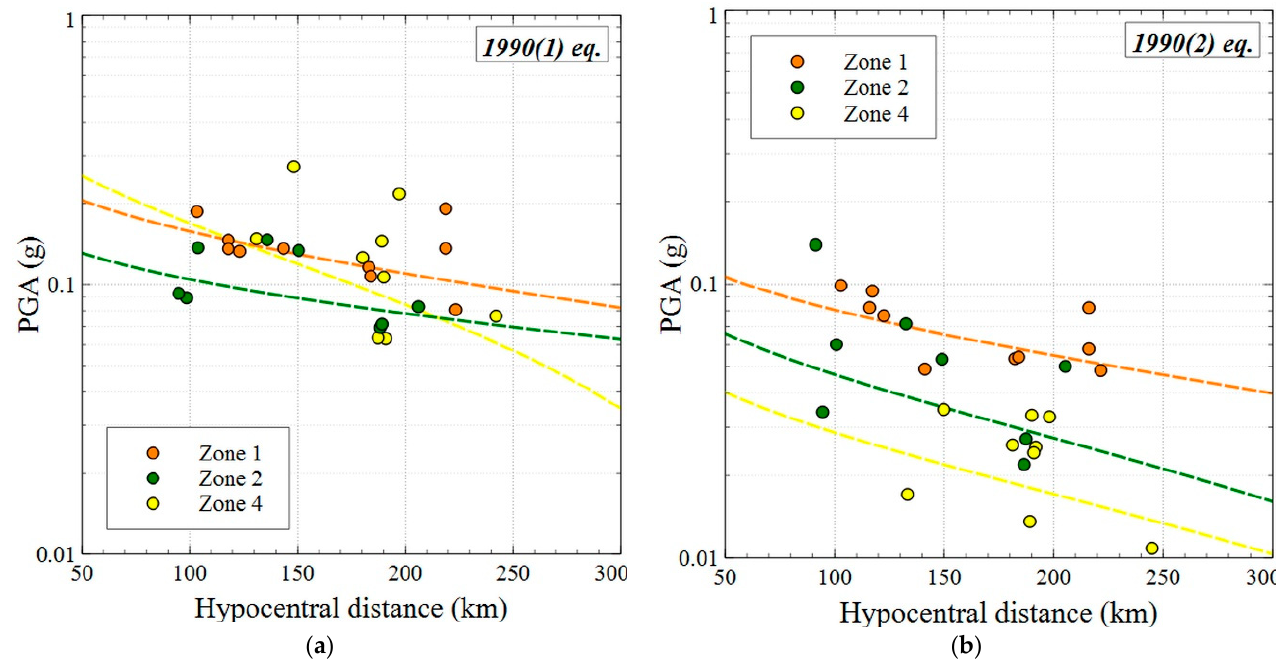
Figure 9. Comparison between the hypocentral distance attenuation curves for peak ground acceleration for: ( a ) the 1990(1) Vrancea earthquake; ( b ) the 1990(2) Vrancea earthquake. With dashed lines are shown the corresponding logarithmic fit curves.